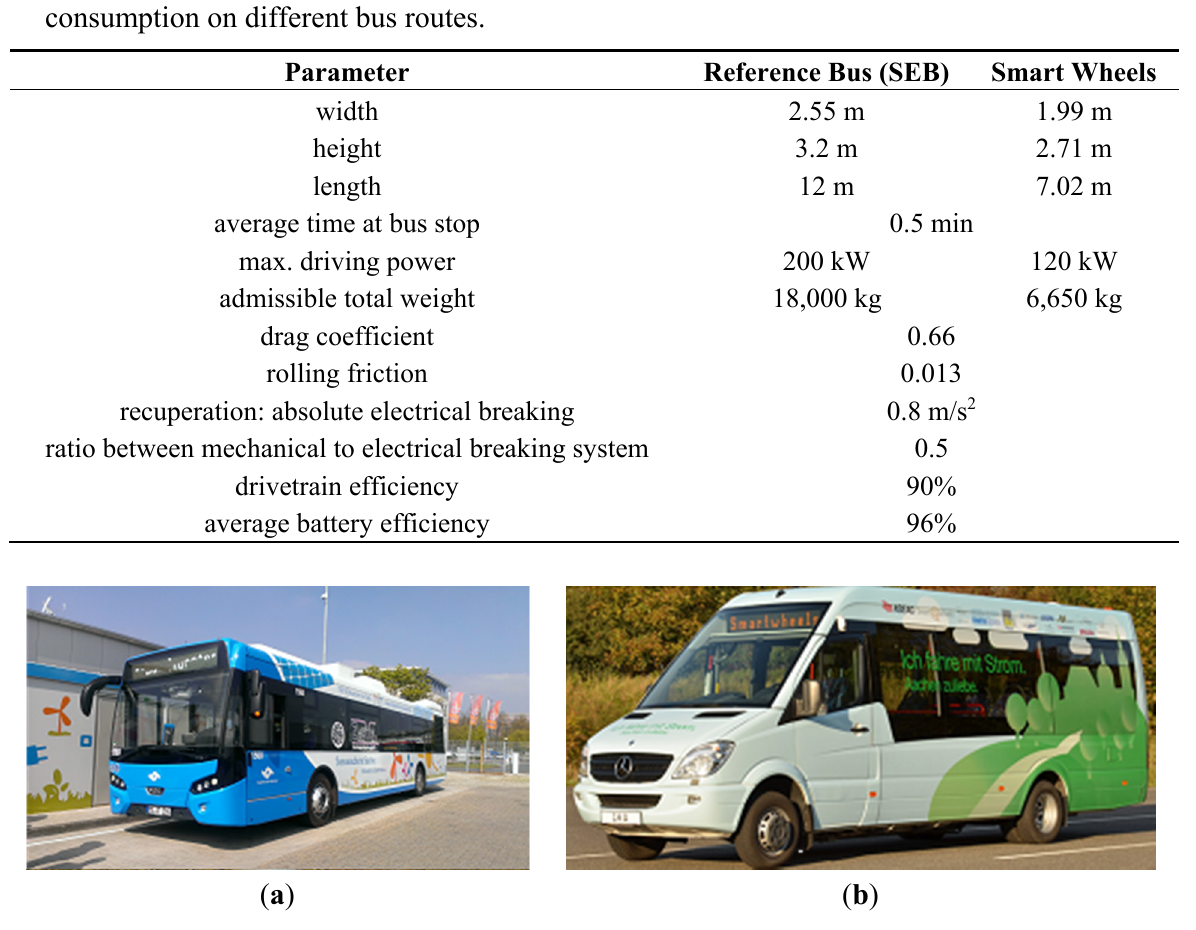
Figure 2. SEB bus ( a ) with 500 kW charging infrastructure and ( b ) Smart Wheels inner city